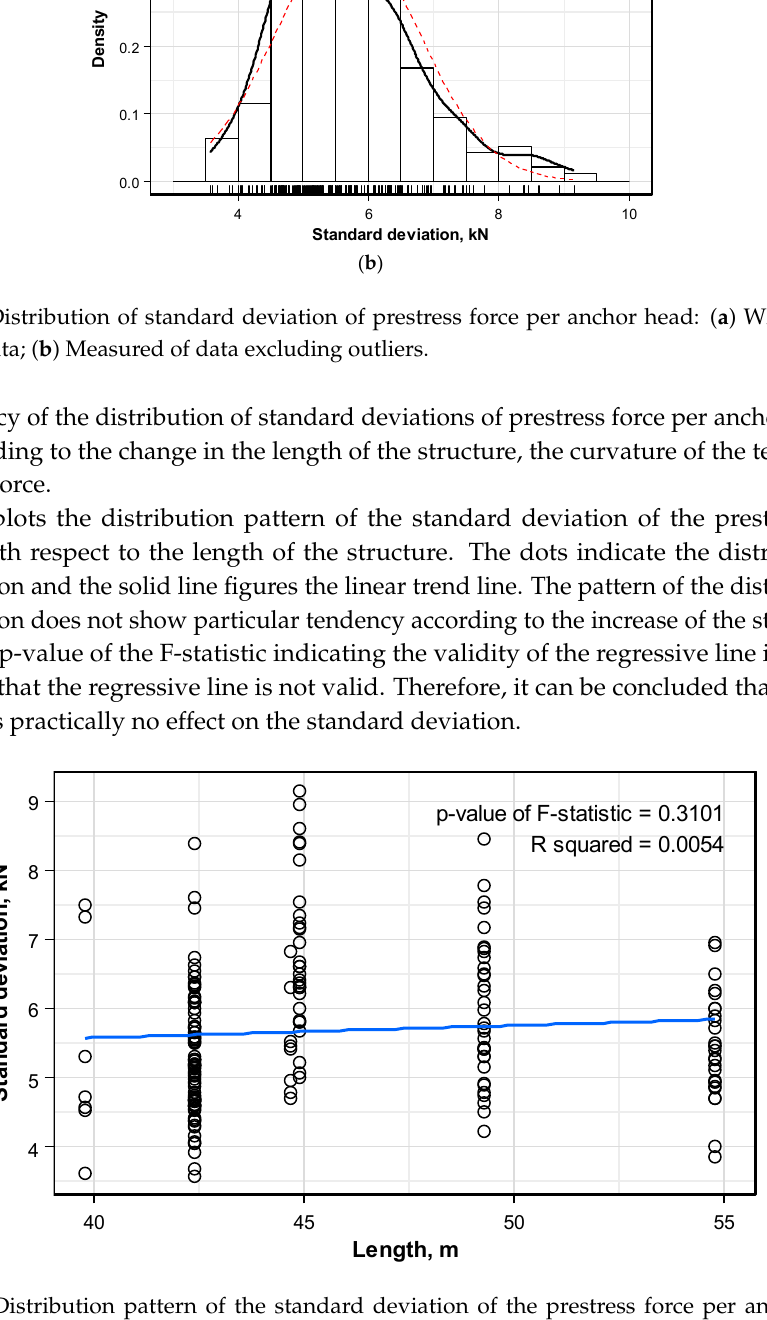
Figure 11. Distribution pattern of the standard deviation of the prestress force per anchor head according to the structure length.